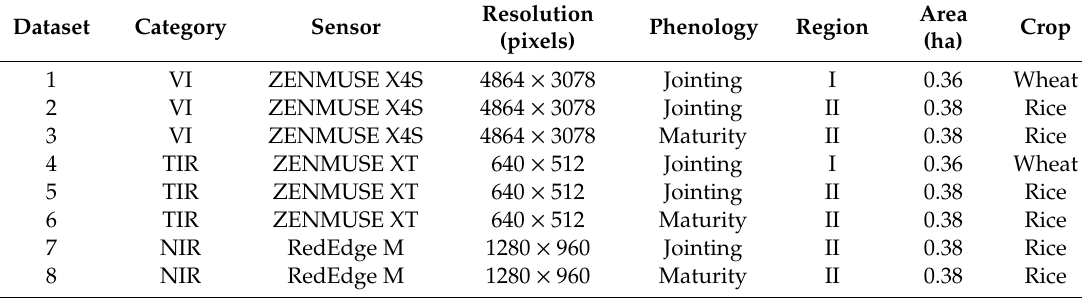
Figure 3. Region I and II of the research area in Xinghua, Jiangsu Province, China. Table 1. UAV image data used in the experiment.